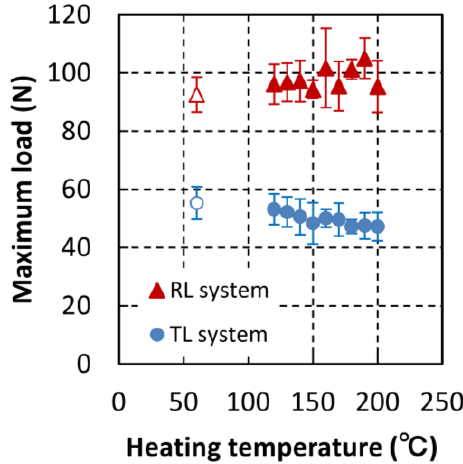
Figure 4. Dependence of maximum load on heating